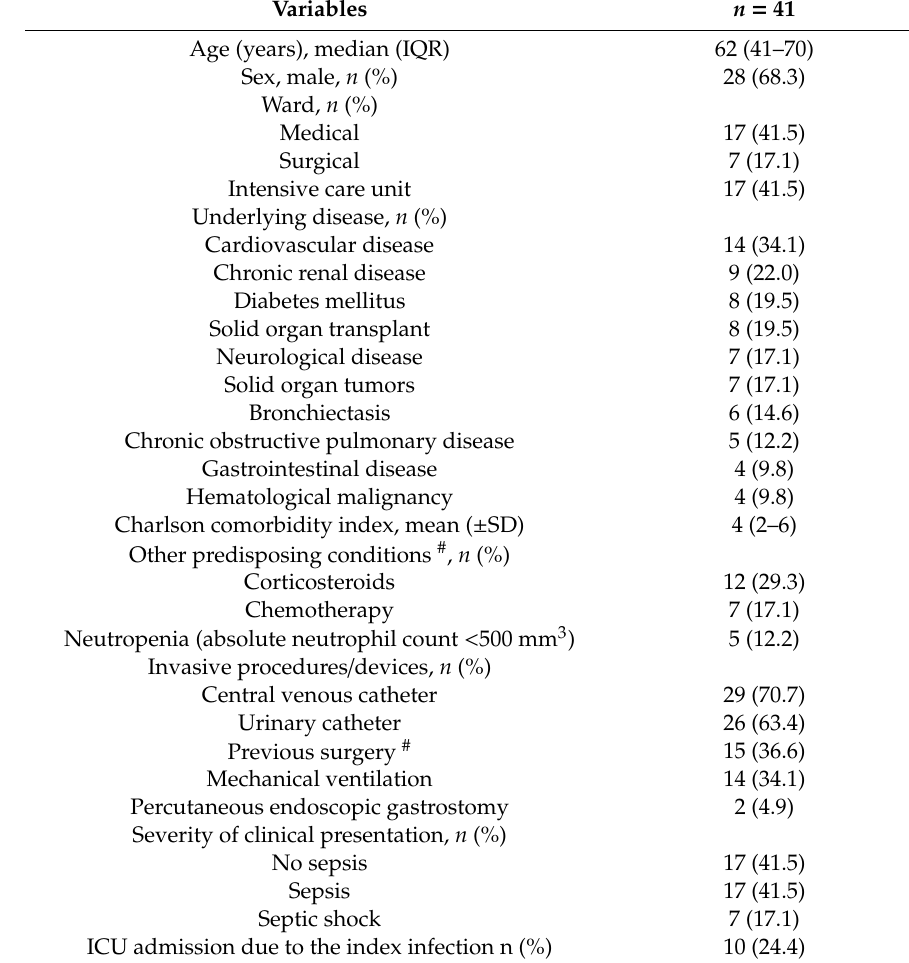
Table 1. Baseline demographics and clinical